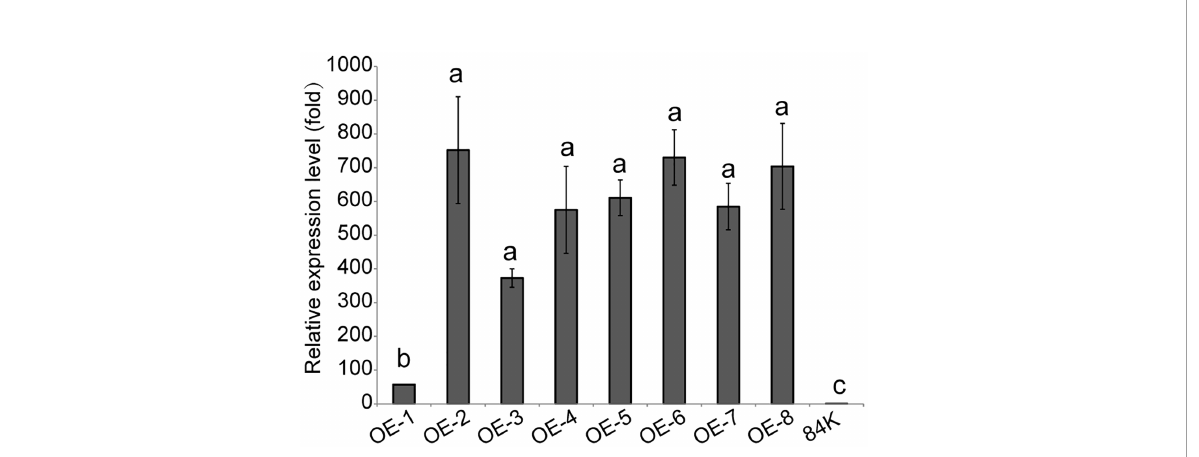
FIGURE 2 Expression of PagSAMT in eight lines of transgenic poplars. OE-1 to OE-8 indicates transgenic poplars containing overexpressed PagSAMT . 84K indicates the wild-type poplar with normal SAMT expression. RT-qPCR was performed with PagSAMT -speci fi c primers. When the tissue culture seedings of each line grew to 10 cm tall, RNA was extracted from the middle of leaves. Expression values were normalized to the expression levels of the 84K poplar b -Tubulin gene in respective lines. The level of PagSAM expression in the 84K poplar was arbitrarily set at 1.0. Each bar represents the mean relative expression level of three independent experiments with the standard errors. Statistical differences in the means are indicated with different letters, p < 0.05